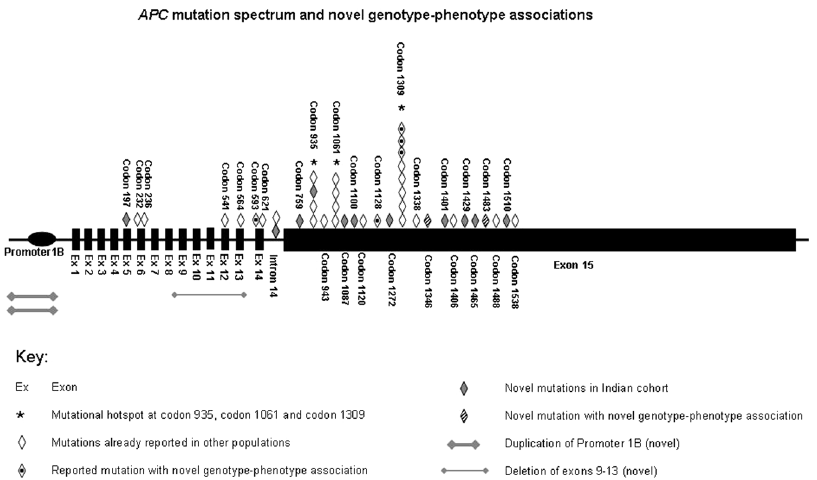
Figure 1. APC mutation spectrum and novel genotype-phenotype associations. The mutation distribution shows clustering of two thirds of all APC mutations in proximal Exon 15, with three Indian mutational hotspots (codon 935, 1061 and 1309) contributing to one third of all APC mutations. Large number of novel APC mutations (n = 15) and few novel genotype phenotype associations for codon 1228, 1346 and 1483 mutations.